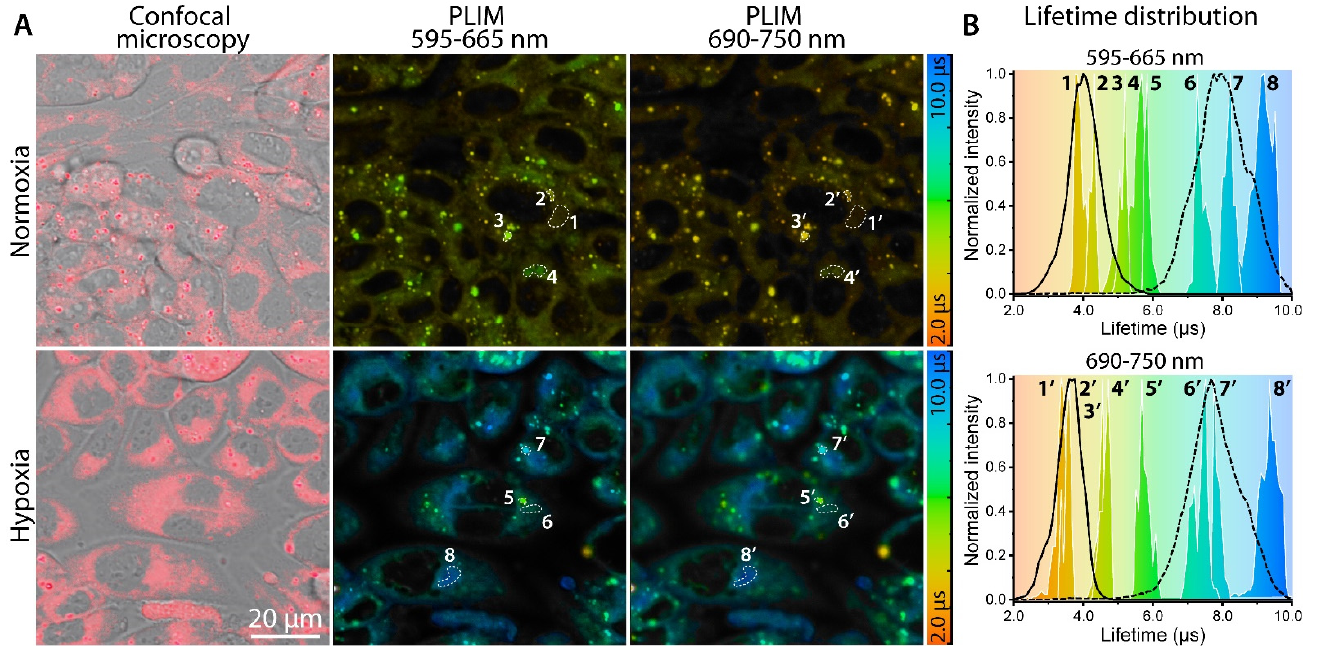
Figure 5. ( A ). Confocal/DIC (left column) and PLIM (middle and right columns) microphotographs of CHO-K1 cells incubated with 0.3 mg/mL Pt1@PCL- b -PEG (12.1 wt.% Pt1 ) for 24 h under normoxic (top row) and hypoxic (bottom row) conditions at 37 ° C. Numbers denote selected areas in red (1–8) and deep-red (1’–8’) channels ( B ). Lifetime distributions of the selected areas (1–8 and 1’–8’) recorded in red channel (595–665 nm; top panel) and deep-red channel (690–750 nm; bottom panel) overlaid with the lifetime distributions across the image for normoxia (solid lines, 2–5 μ s) and hypoxia (dashed lines, 6–10 μ s). Excitation: 405 nm; Detection: 663–738 nm (confocal microscopy; left column); 595–665 nm (PLIM; middle column); 690–750 nm (PLIM; right column). Scale bar: 20 μ m.